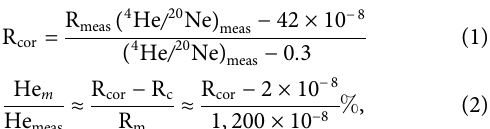
Frontiers in Earth Science |